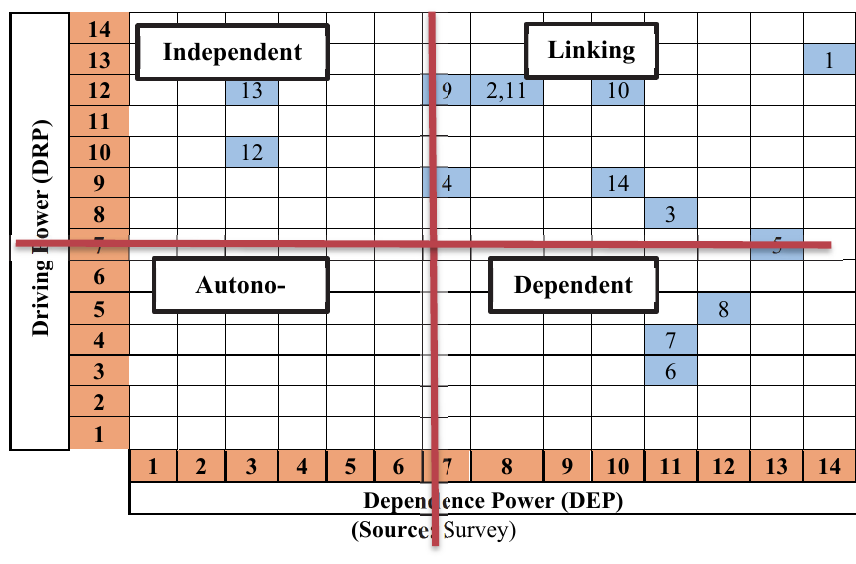
Fig. 2. Classification of DT Enablers